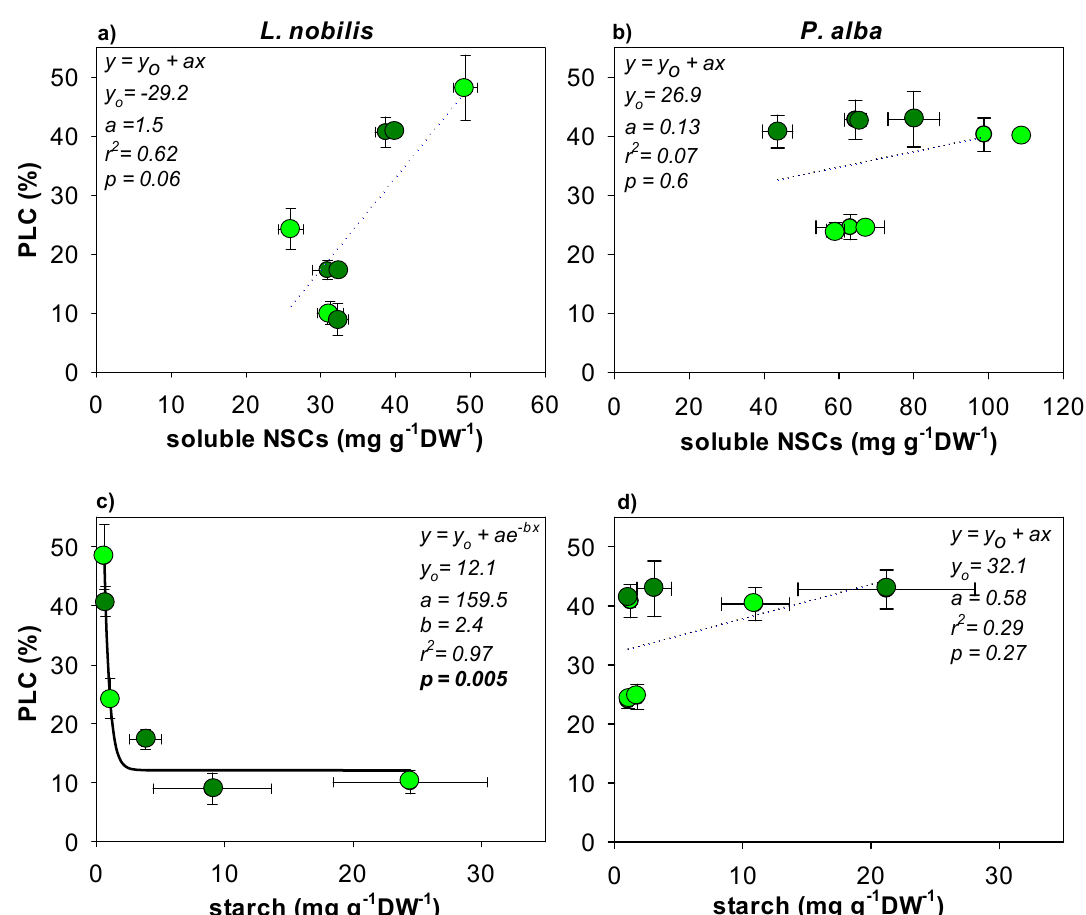
Figure 5. Relationships between percentage loss of hydraulic conductivity (PLC) and ( a , c ) soluble NSCs and ( b , d ) starch content as recorded in control (light green) and woody tissue-shaded (dark green) stem of L. nobilis and P. alba stem samples. Regression equation (dotted and solid lines for correlation with p > 0.05 and p < 0.05, respectively), coefficient values, correlation coefficients (r 2 ) and p -values are also reported.